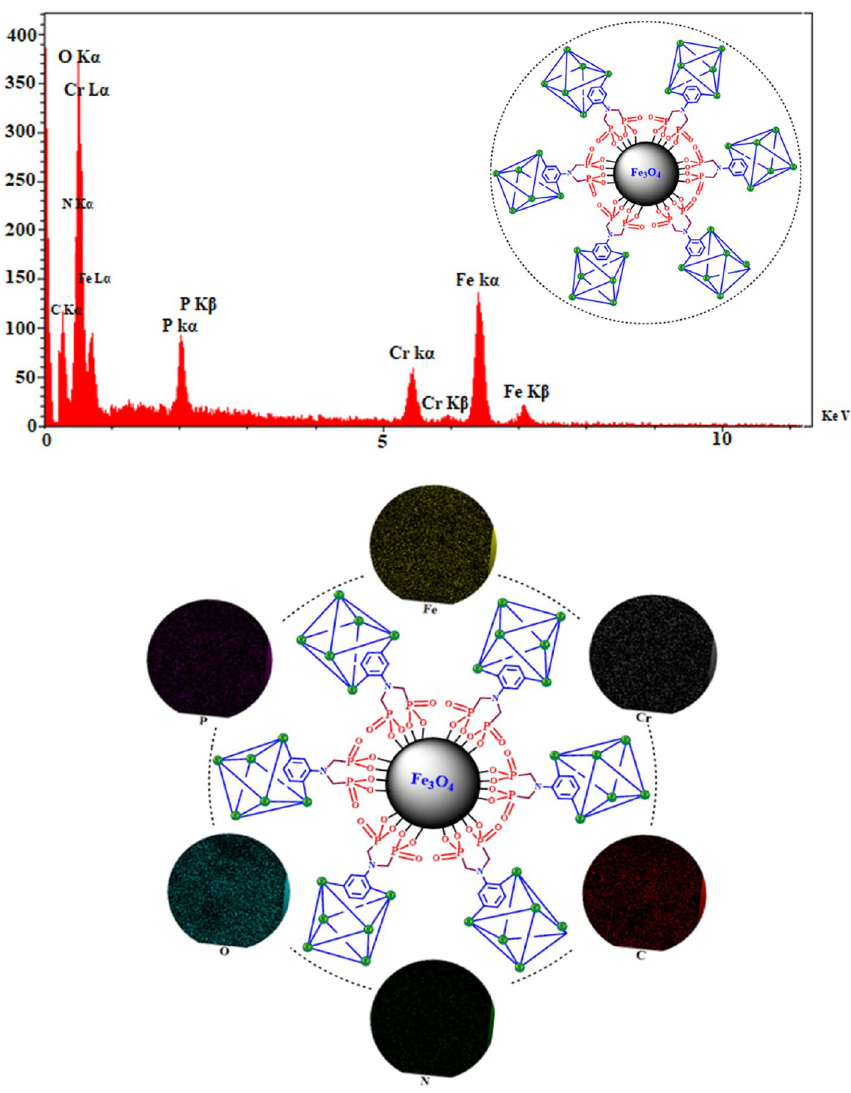
Figure 6. Fe 3 O 4 @MIL-101(Cr)-N(CH 2 PO 3 ) 2 : (a) EDX analysis. (b) Elemental mapping of C (red), O (blue), N (green), Fe (yellow), P (purple) and Cr (gray)